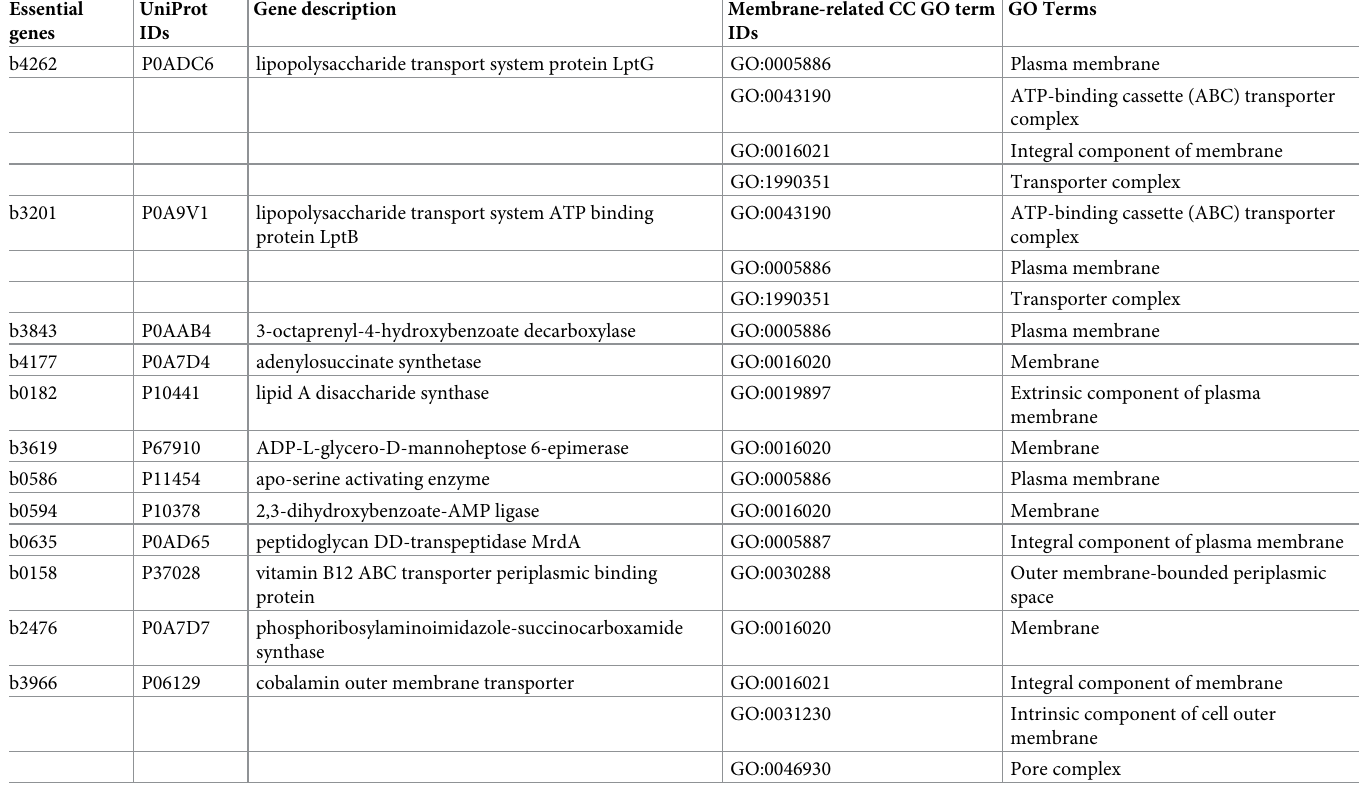
Table 1. Membrane-related essential